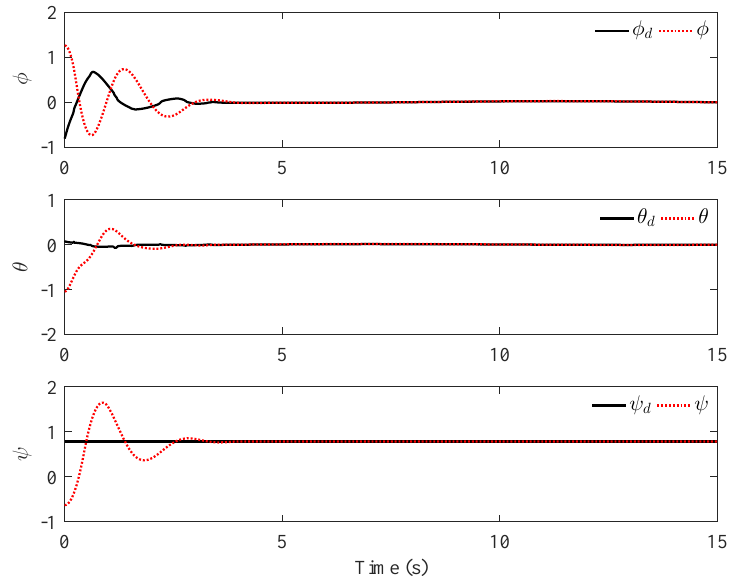
Figure 3. The tracking curves of the attitude subsystem.